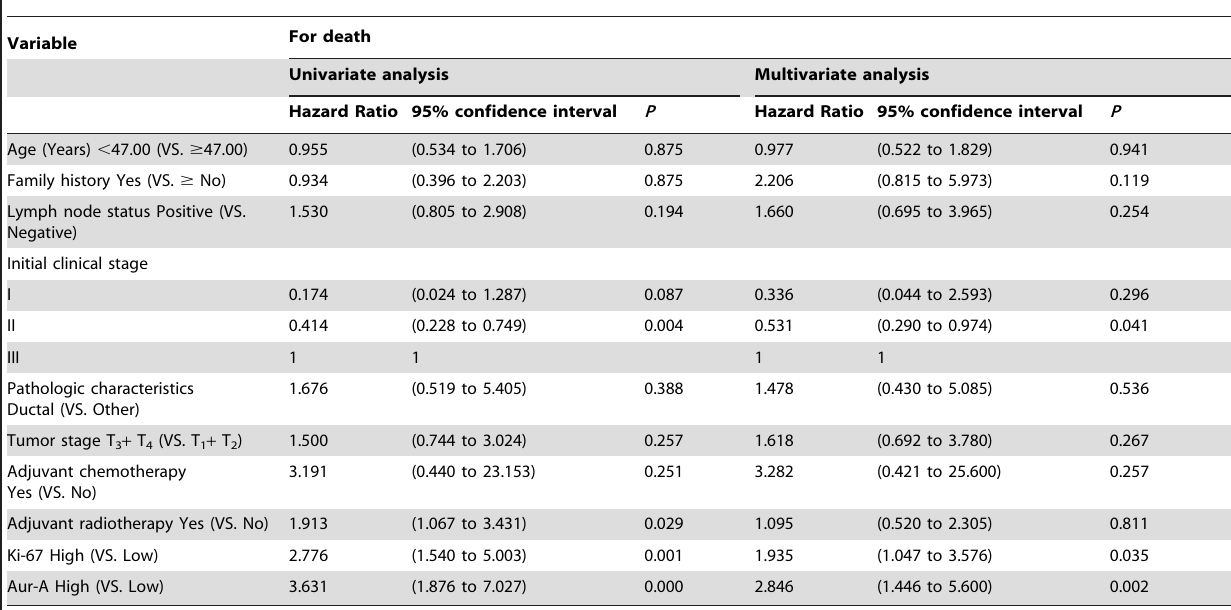
Table 3. Results of univariate and multivariate Cox proportional-hazards analysis in TNBC patients for overall survival (n=122).